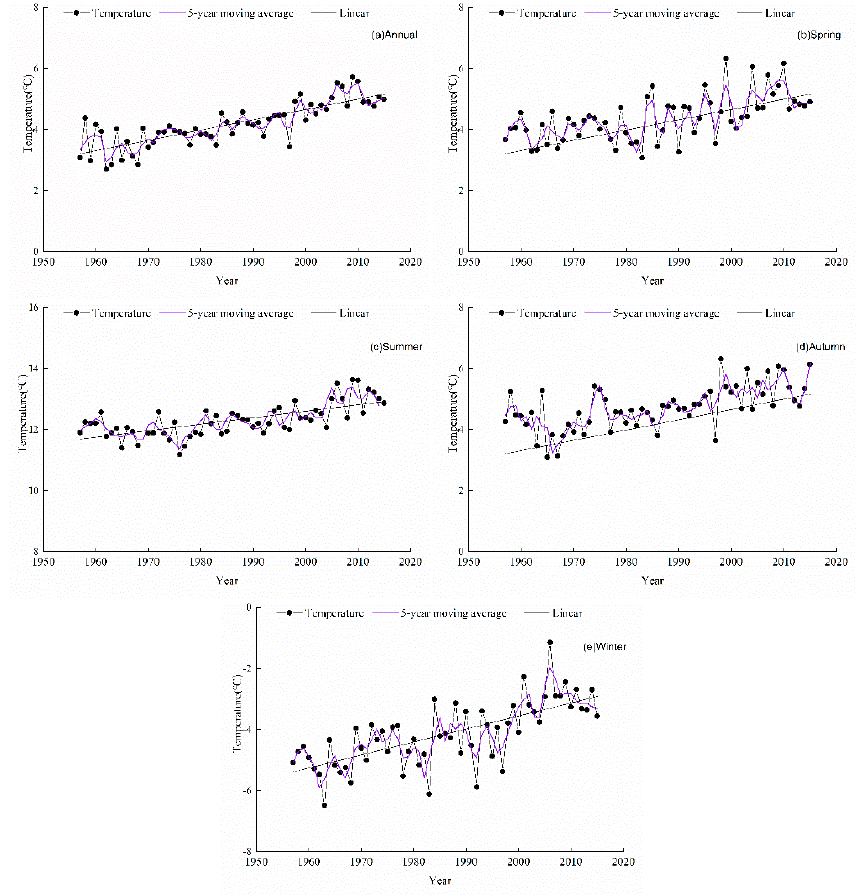
Figure 4. Annual average air temperature and seasonal average air temperature trends in the YLZR basin from 1957 to 2015.